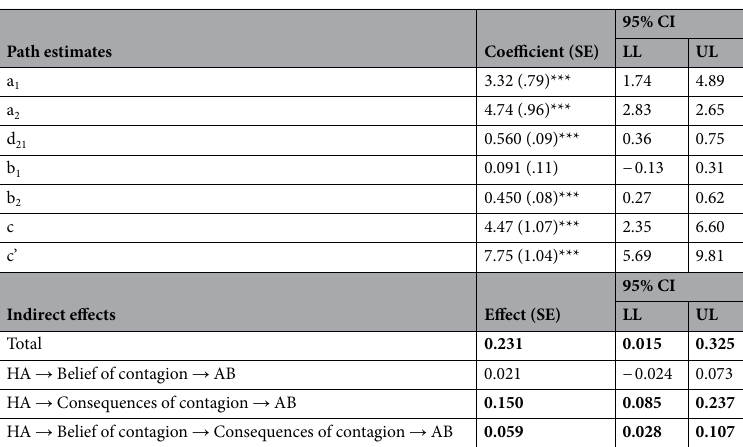
Table 2. Serial mediation model predicting attentional bias (N = 132). Coefficient, non-standardized B coefficients SE standard errors, CI bias-corrected and accelerated 95% confidence interval, LL lower limit,